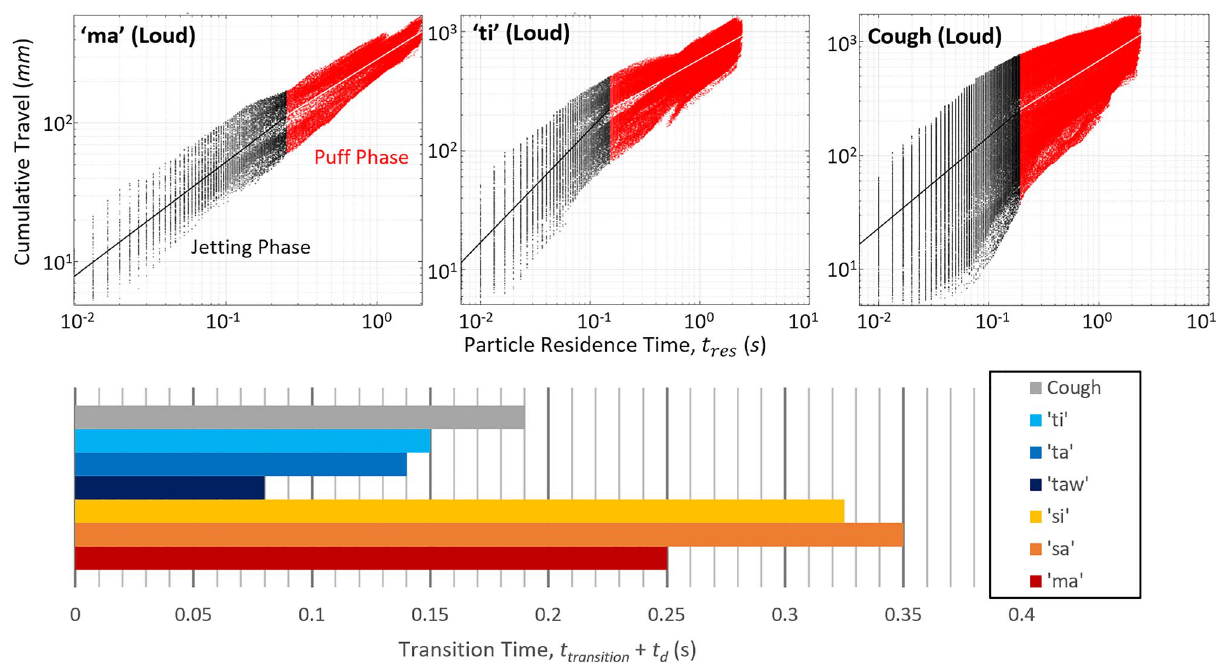
Figure 5. Time-cumulative displacement tracks of aerosol particles for loud vocalizations and cough.